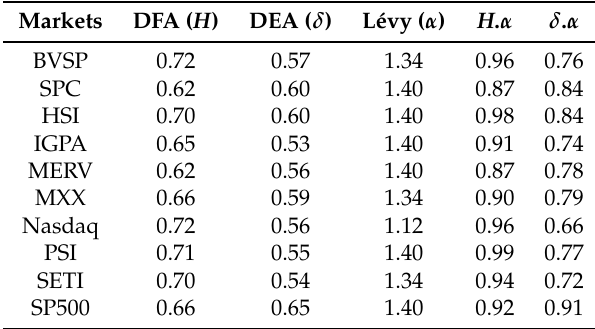
Table 3. Scaling exponents of various financial markets.